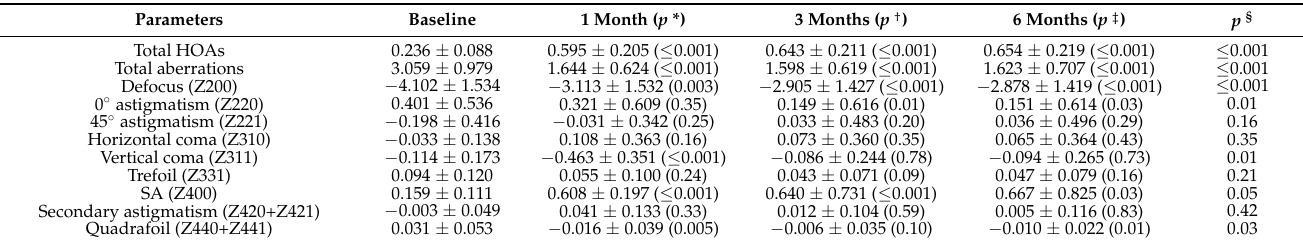
Table 3. Changes in aberration values (mean of root-mean-square ± SD, µ m) after wearing Orthoker- atology